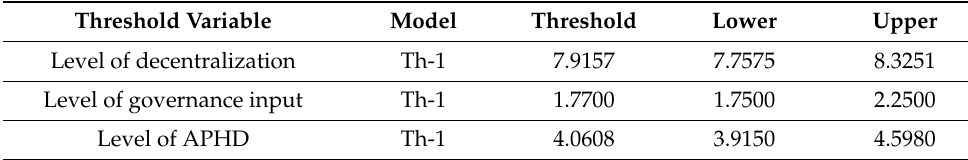
Table 6. The estimation of single threshold point.